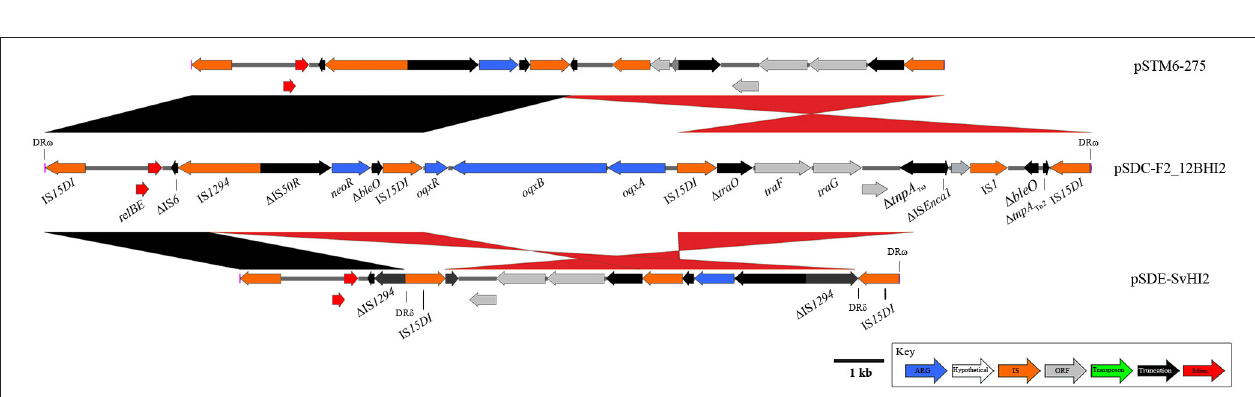
FIGURE 5 | Diagrams and comparisons of an IS 15DI- mobilized composite transposon. Composite transposon captured by IS 26 variant IS15DI , mobilizing the neomycin resistance gene neoR . pSDC-F2_12BHI2 (center) also hosts a Tn 6010 -like element, inserted at the central IS 15DI .